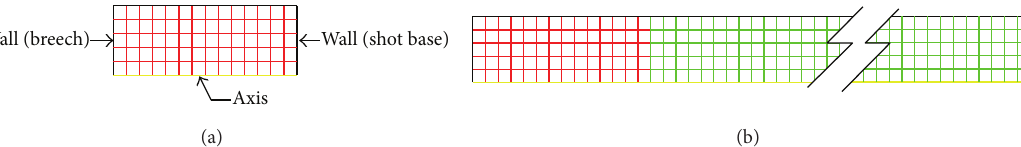
Figure 2: Computational domain mesh: (a) initial mesh generated by Gambit. (b) Final mesh, after the end of the simulation by Fluent.